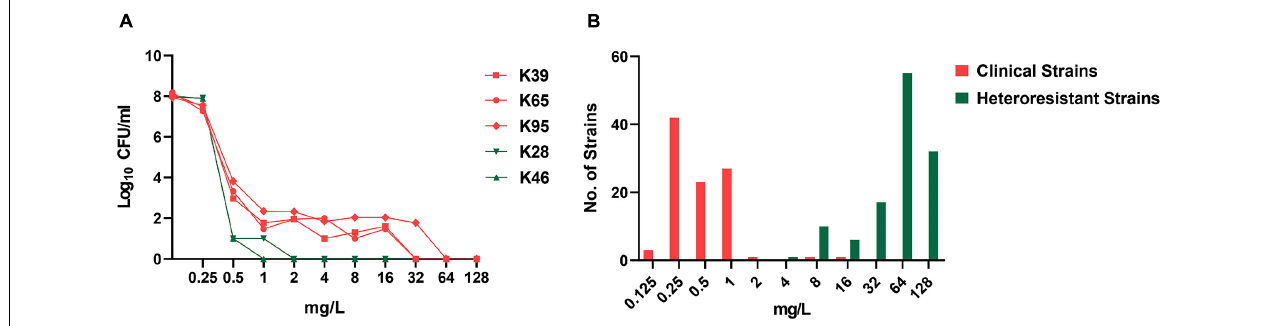
FIGURE 1 | Population analysis profiling (PAP) for the identification of colistin heteroresistance and minimum inhibitory concentration (MIC) distribution of resistant subpopulations. (A) PAP of five representative strains with (K39, K65, and K95) or without (K28 and K46) colistin heteroresistance. (B) MIC distribution of clinical strains and resistant subpopulations selected in the PAP assays.